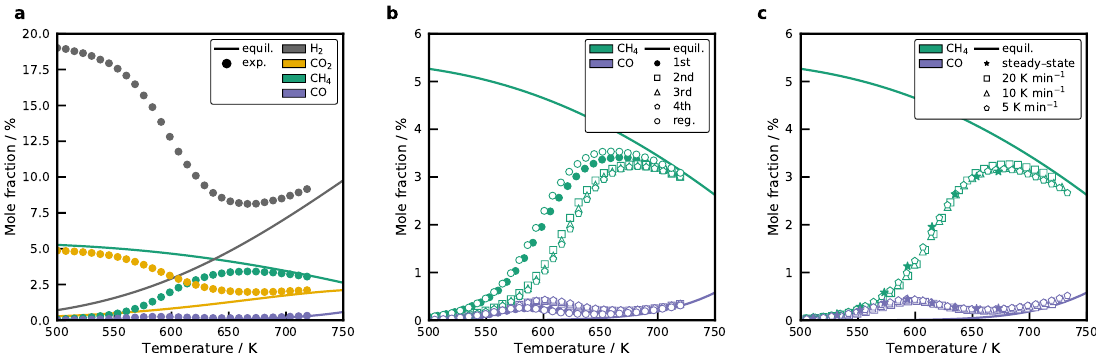
Figure 9. ( a ) Concentration profile (on a dry basis) of the temperature-scanning experiment for the catalyst formed using BB(8), 10wt%, and calcined at 673K (1b) compared to the equilibrium composition. ( b ) Repeated temperature-scanning results for the 1b catalyst with a temperature ramp of 20Kmin − 1 . After the fourth run, the sample was regenerated by oxidation in synthetic air at 773K and reduced again. ( c ) Comparison of temperature-scanning profiles for different scanning rates, as well as steady-state results for the 1b sample. Experimental data is reduced for presentation. Conditions: m cat = 30mg, WHSV = 100L N h − 1 g − 1